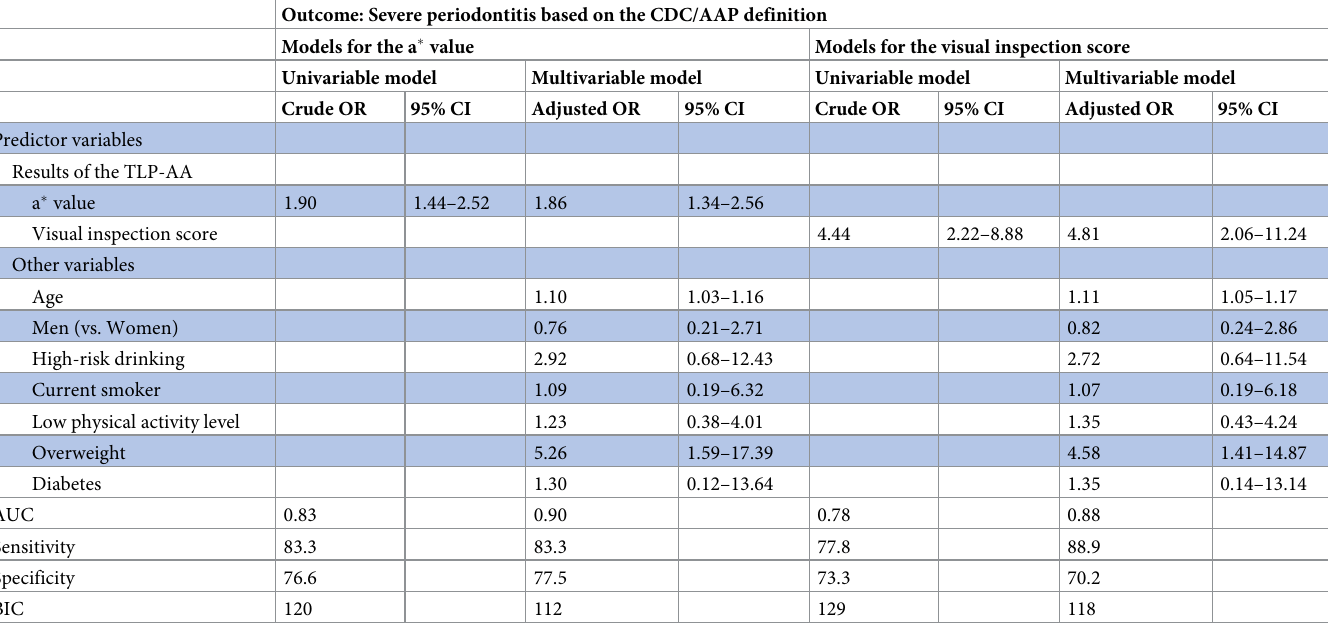
Table 3. Logistic regression models for periodontitis among Japanese workers ( n =